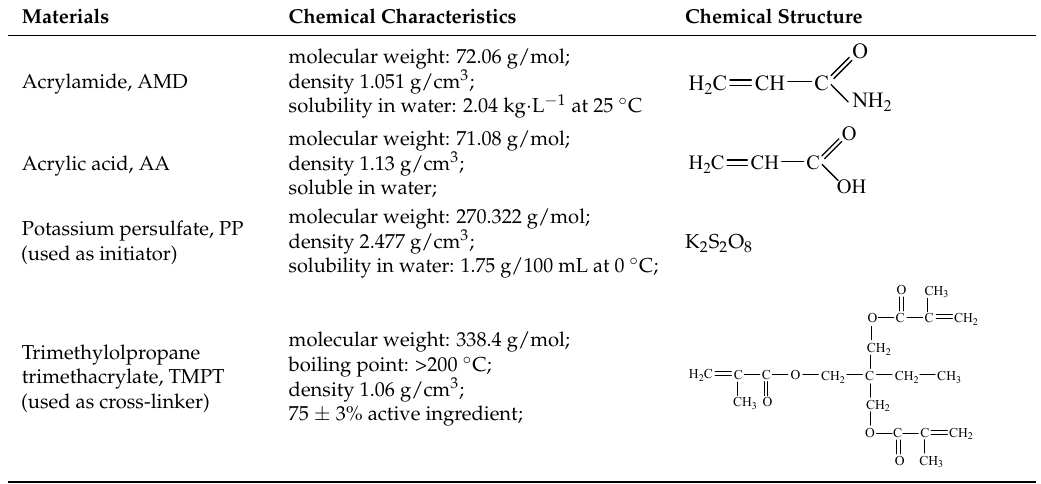
Table 1. The materials used for hydrogel preparation.